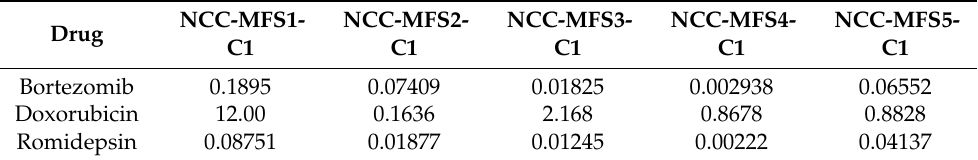
Figure 5. Cell viability of MFS cell lines at different concentration of each drug: ( a ) bortezomib, ( b ) doxorubicin, and ( c ) romidepsin. Data concerning NCC-MFS1-C1, NCC-MFSS2-C1, and NCC- MFS3-C1, and NCC-MFS4-C1 were previously reported [28–31]. Table 3. Half-maximal inhibitory concentration (IC 50 ) values ( μ M).